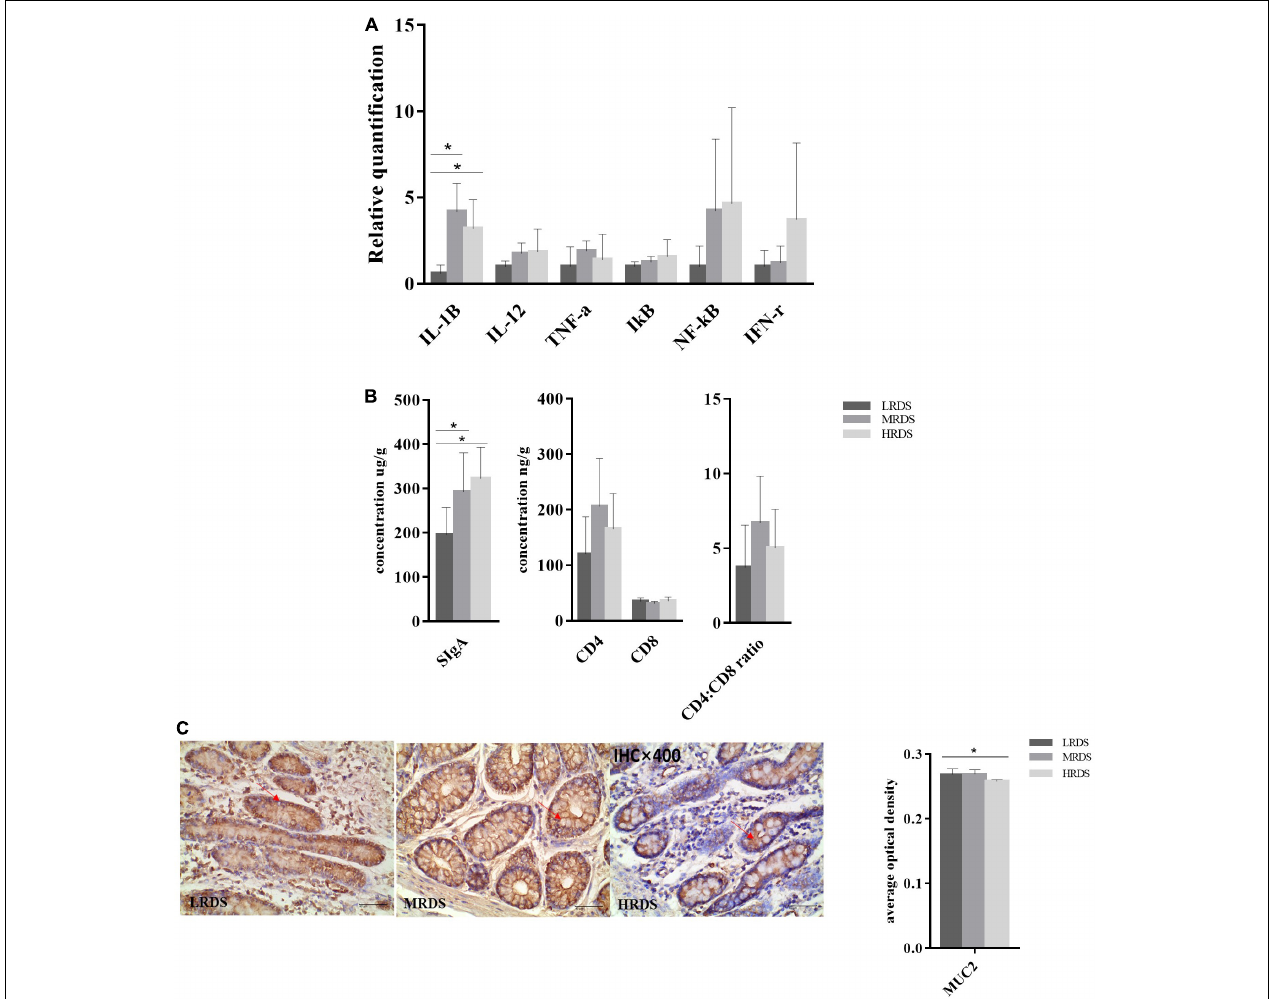
FIGURE 9 | Intestinal mucosal immune in cecum. (A) Gene expression in the cecal mucosa. Glyeraldehyde 3-phosphate dehydrogenase (GAPDH) was used as the reference gene for gene expression including IL-1 β , IL-12, I κ B, NF- κ B, TNF- α , and IFN- γ . (B) Antigen specific proteins expression of SIgA , CD4 + T cell, CD8 + T cell, and CD4 + : CD8 + ratio in the cecal mucosa. (C) Antigen specific proteins expression of Muc2 and tissue localization of Muc2 in the cecum. The goblet cells contain Muc2 (brown), and mucin stains are shown in serial sections on the same tissue area.